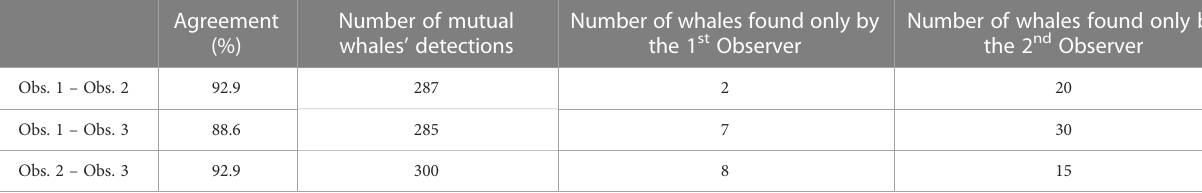
TABLE 4 Annotation agreement on the test subset between the three